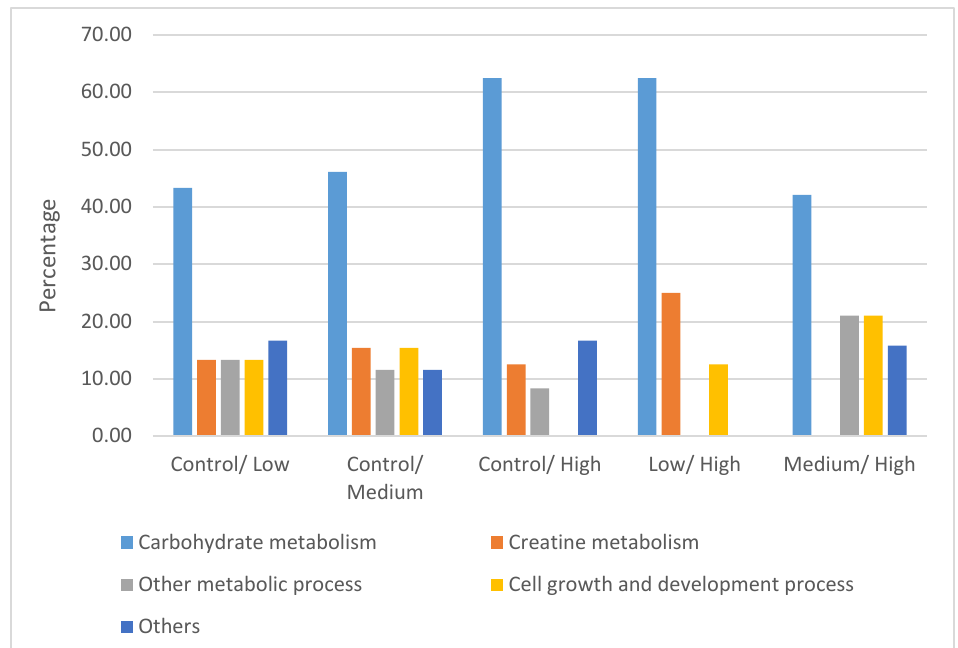
Figure 5. Classifications of differentially expressed proteins according to the functional roles in the following categories: carbohydrate metabolism, creatine metabolism, other metabolic process, cell growth and development process and others. Table 3. Top 10 differentially expressed proteins in the Control vs. Low, Control vs. Medium, Control vs. High, Low vs. High and Medium vs. High groups. UniProt Accession